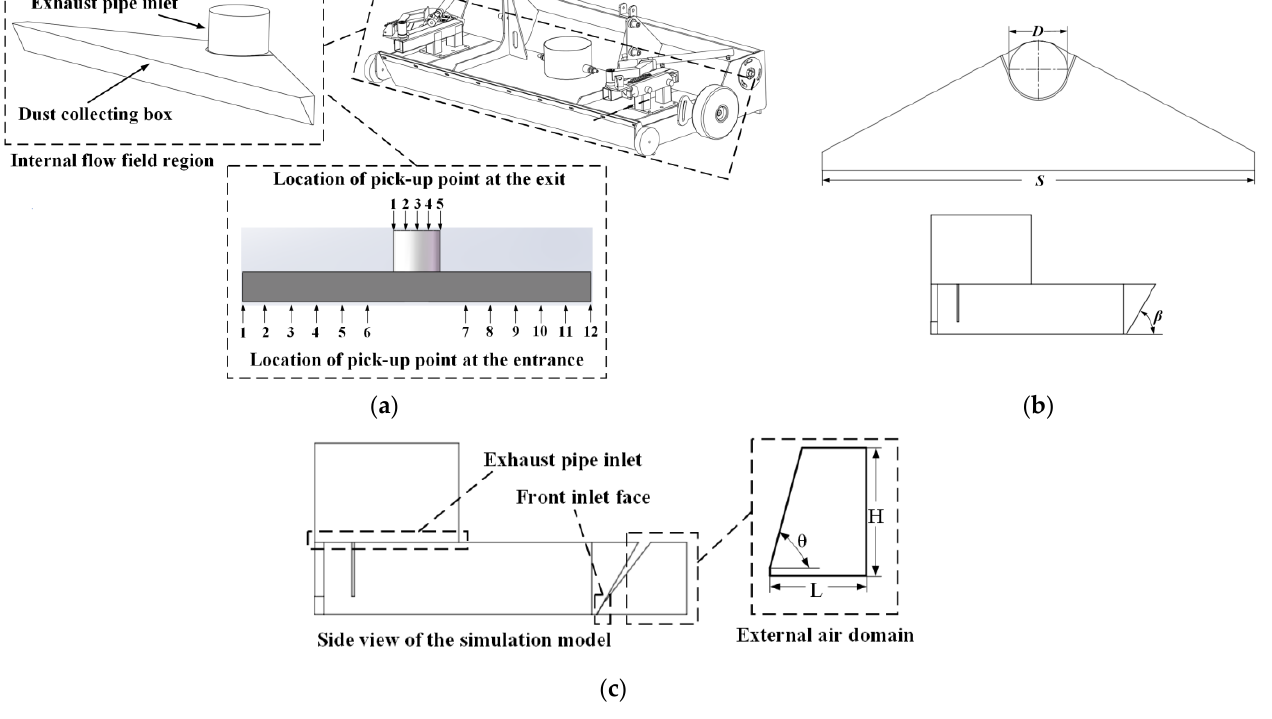
Figure 1. Internal flow field region and its structural parameters: ( a ) internal flow field region and the location of the measurement points; ( b ) internal flow field region structural parameters; ( c ) simulation model and external air domain structural parameters. Table 1. The specific dimensions of the dust suction